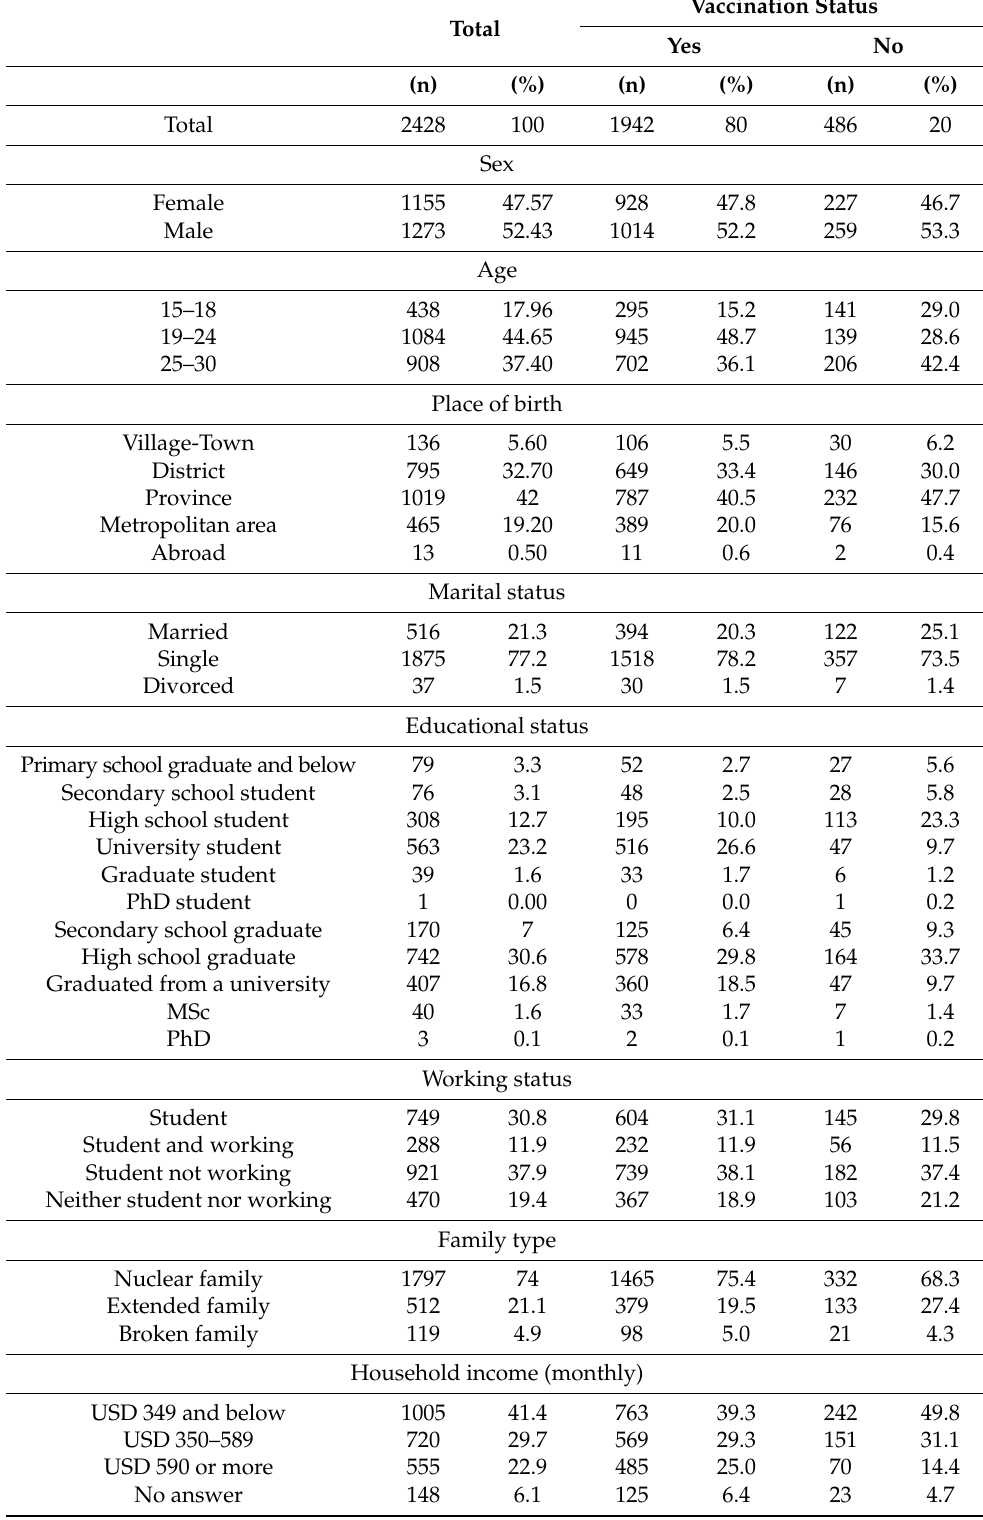
Table 1. The sociodemographic characteristics of the research participants and vaccination